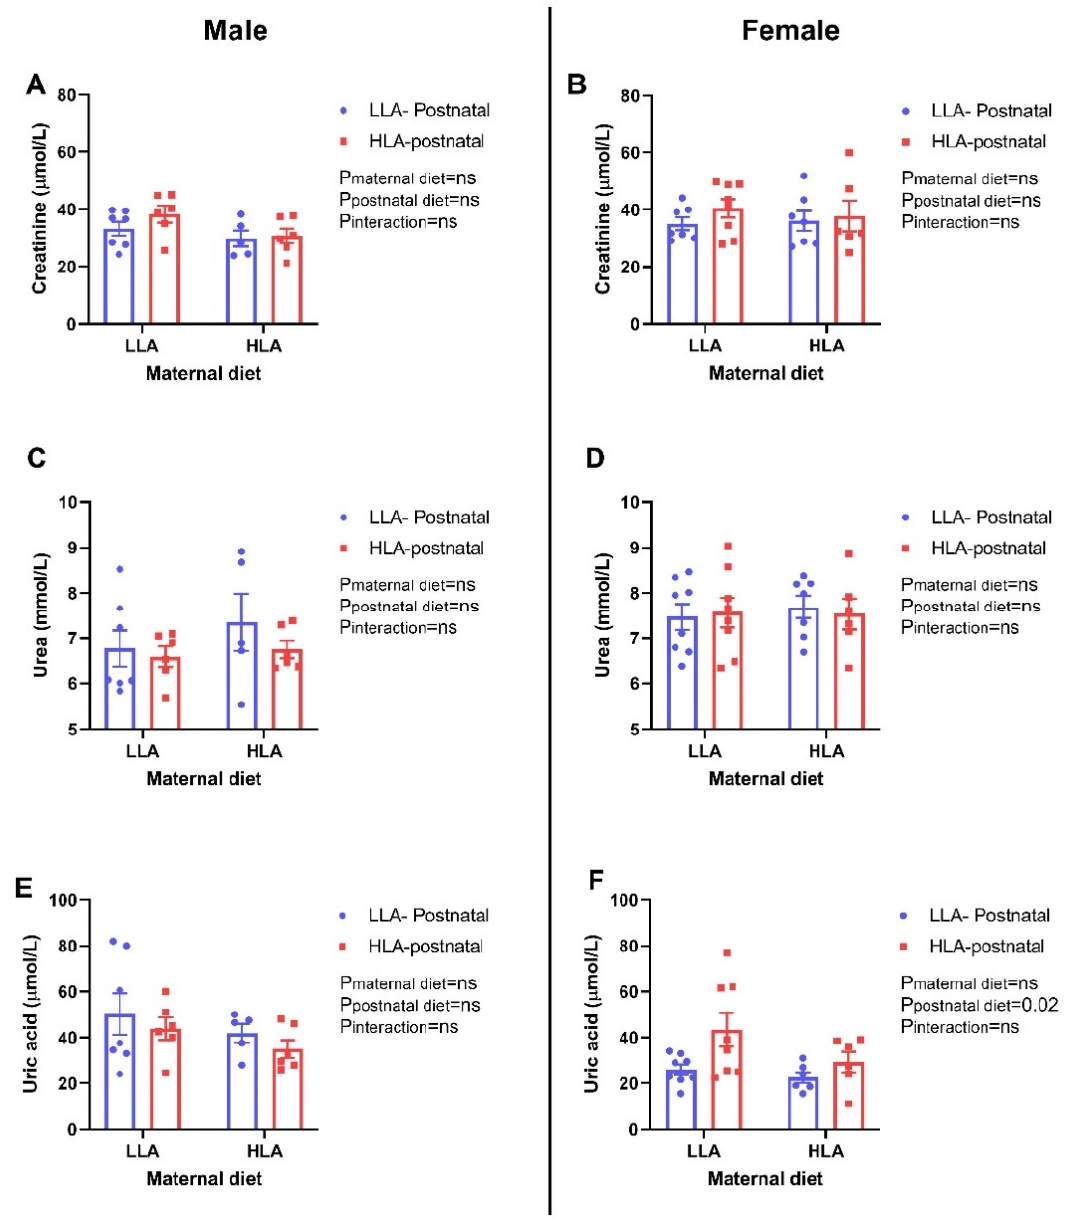
Figure 7. Effect of a maternal and postnatal diet high in linoleic acid on circulating creatinine, urea and uric acid in adult offspring. Data are presented as mean ± standard error of the mean (SEM). Two-way ANOVA was performed for statistical analysis with maternal diet and postnatal diet as two factors. n = 5–8. LLA: low linoleic acid; HLA: high linoleic acid; PN: postnatal. A : Creatinine concentration male; B : Creatinine concentration female; C : Urea concentration male; D : Urea concentration female; E : Uric acid concentration male; F : Uric acid concentration female.